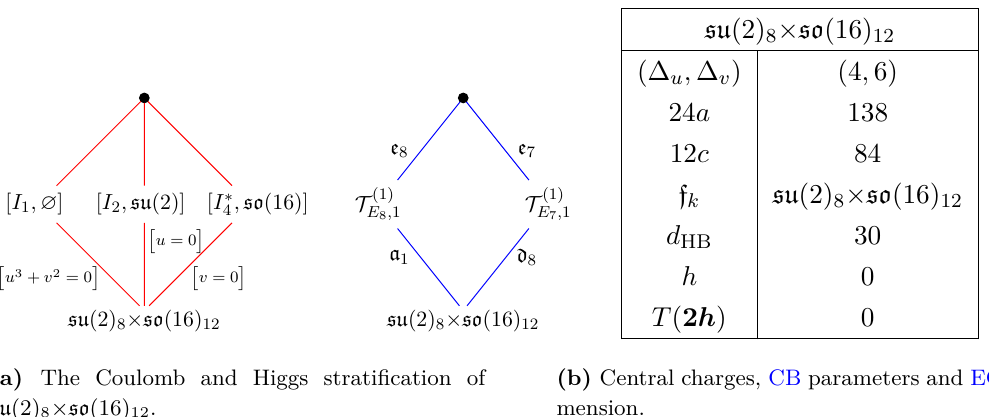
Figure 3. Information about the su (2) 8 × so (16) 12